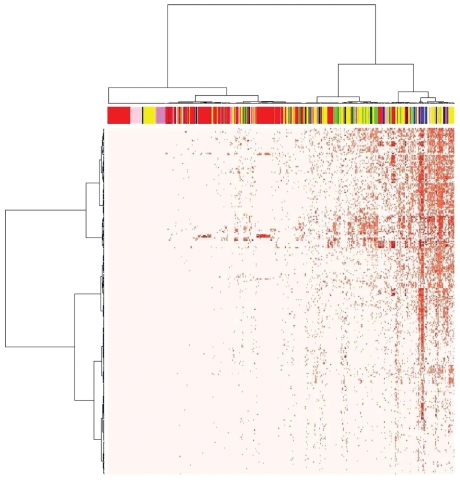
Heat map of 624 assay measurements (including multiple time points where available) in ToxCast phase I data set. Assays are arranged left to right, and chemicals are arranged top to bottom. The color bar at the top indicates the assay type: red (cell-free HTS), violet (multiplexed transcription reporter), yellow (biologically multiplexed activity profiling), green (high-content cell imaging), blue (multiplexed gene expression), pink (cell-based HTS), black (phase I and II XME cytotoxicity), white (real-time cell electronic sensing), and orange (HTS genotoxicity). Data values are –log10(AC50/LEC), where light pink is inactive and darker reds indicate increased activity (lower AC50/LEC).